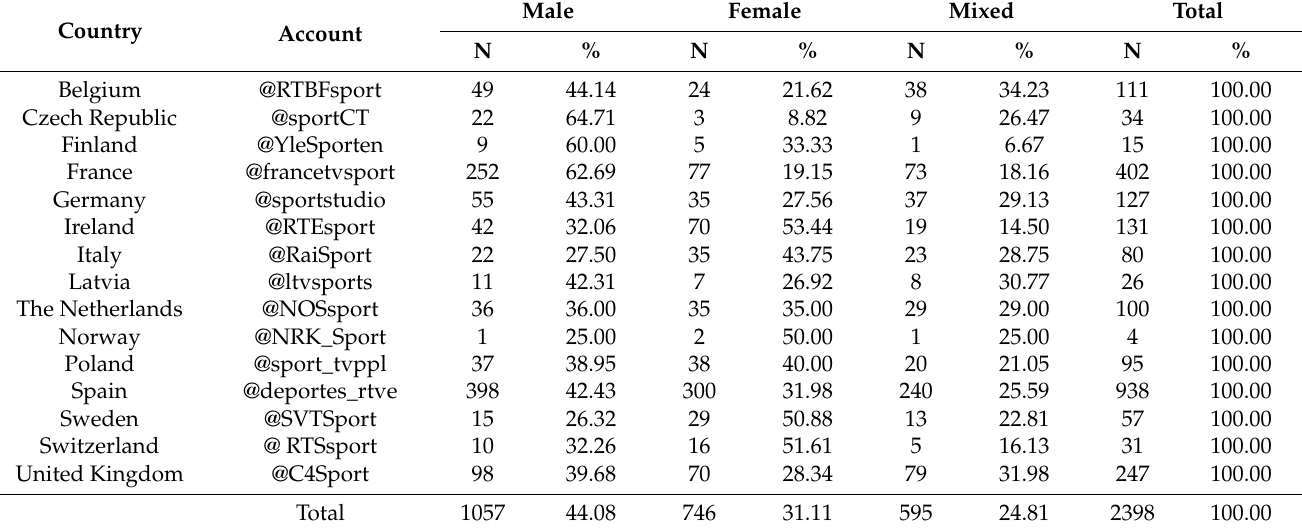
Table 6. Gender of